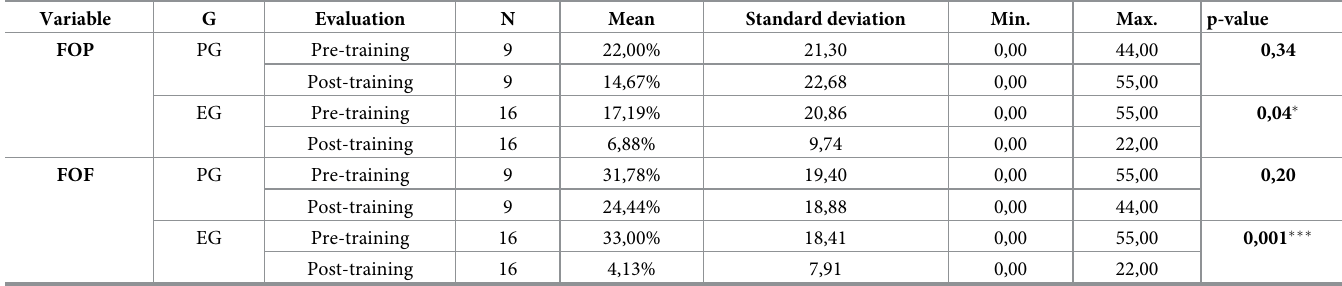
Table 4. Frequency of occurrence of plosives and frequency of occurrence of fricatives in both groups, in all evaluations. Variable G